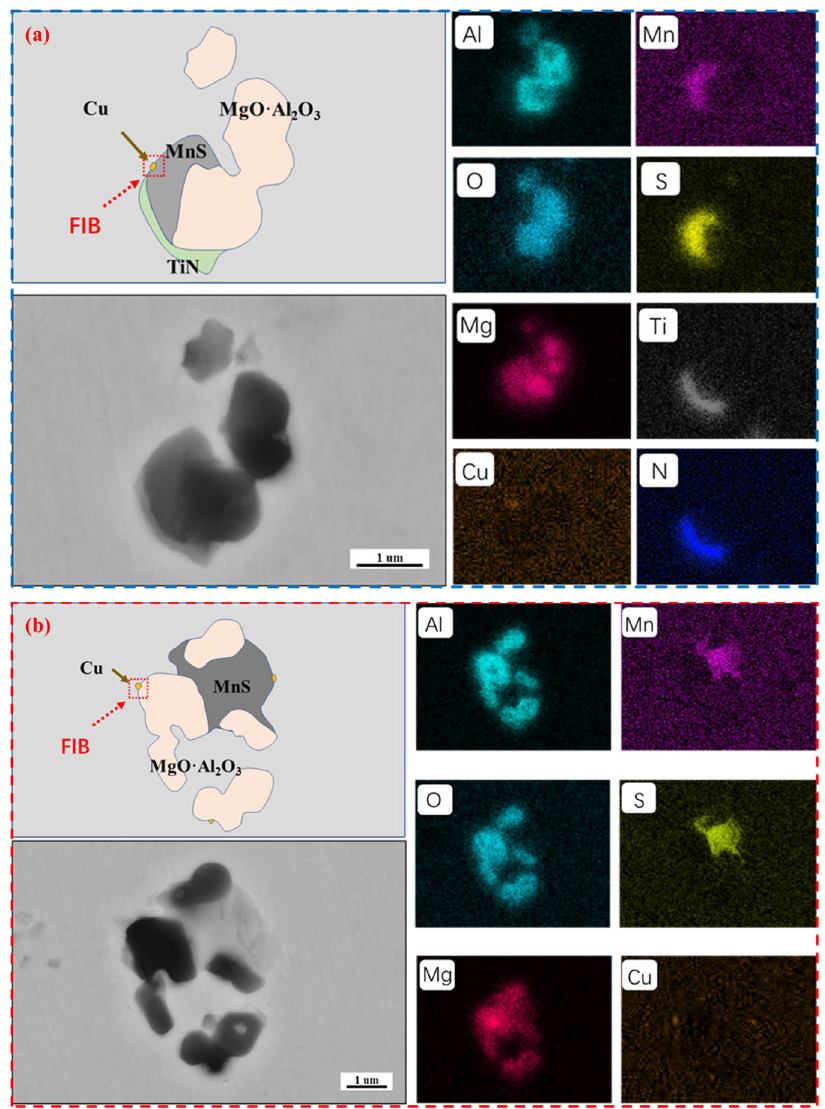
Fig. 6 Segregation characteristics of Cu in inclusions. a The precipitation behaviors of Cu at the TiN – MnS – MgO – Al 2 O 3 inclusion. b The precipitation behaviors of Cu at the MnS – MgO – Al 2 O 3